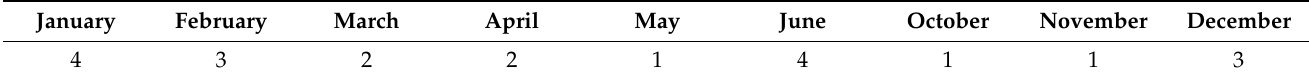
Table 2. Weather conditions w n values.